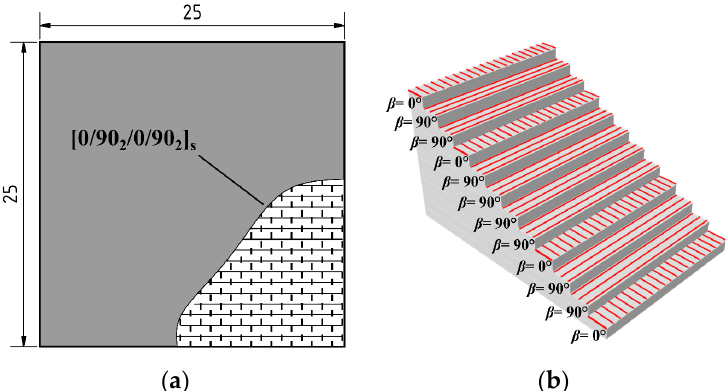
Figure 1. CFRP laminate sample [81]: ( a ) sketch in the x-y plane, and ( b ) LSS details.